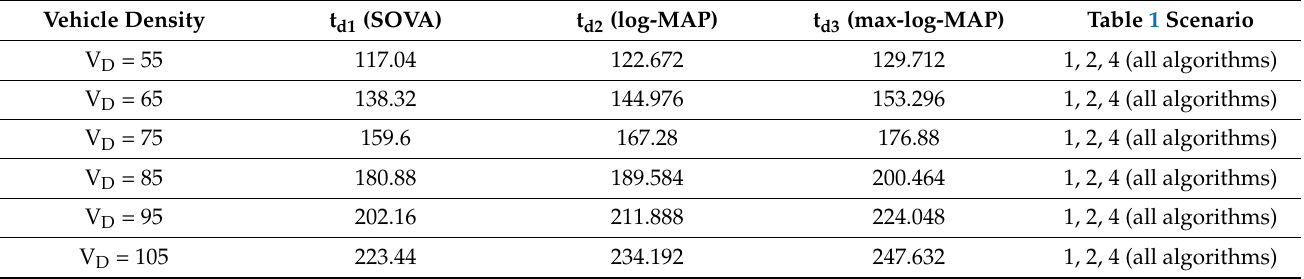
Table 5. Worst case end-to-end latency (ms) and corresponding Table 1 implementation scenario for each algorithm for different vehicle density values, frame length 512 bits, 12 Mbps data rate, 60 km/h